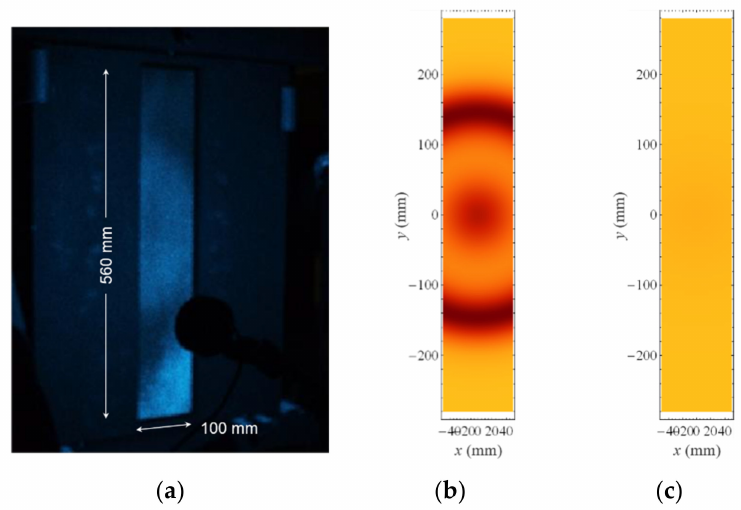
Figure 22. ( a ) diffraction efficiency for the BS-HOE recorded on a 10 mm thick glass plate and reconstructed with divergent laser light of λ = 0.488 µ m. ( b ) model predictions for a 10 mm thick float glass plate with f ( t exp ) adapted. ( c ) model predictions for a 6 mm thick Nextrema ®